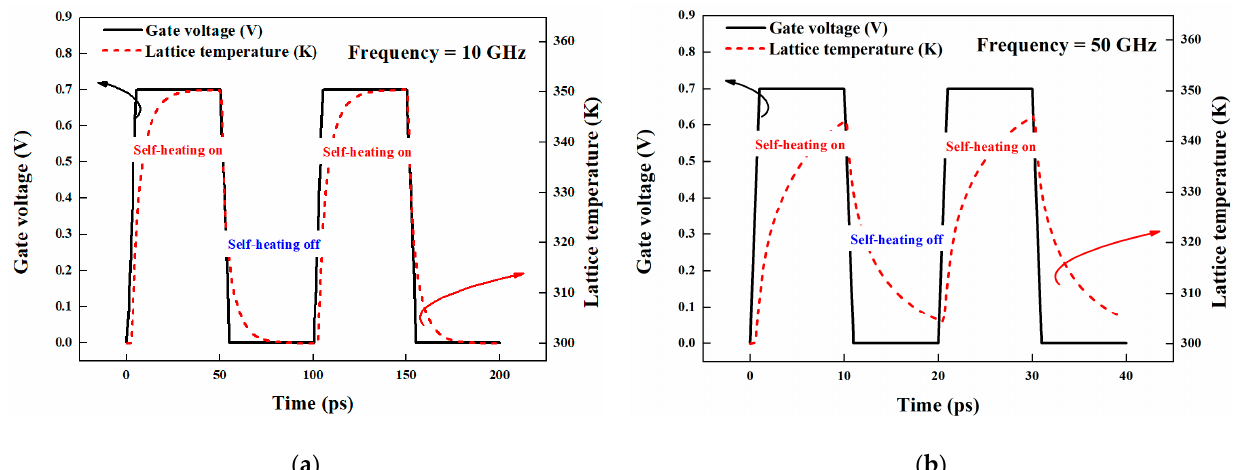
Figure 3. Lattice temperature response to the gate voltage of ( a ) 10 GHz and ( b ) 50 GHz.